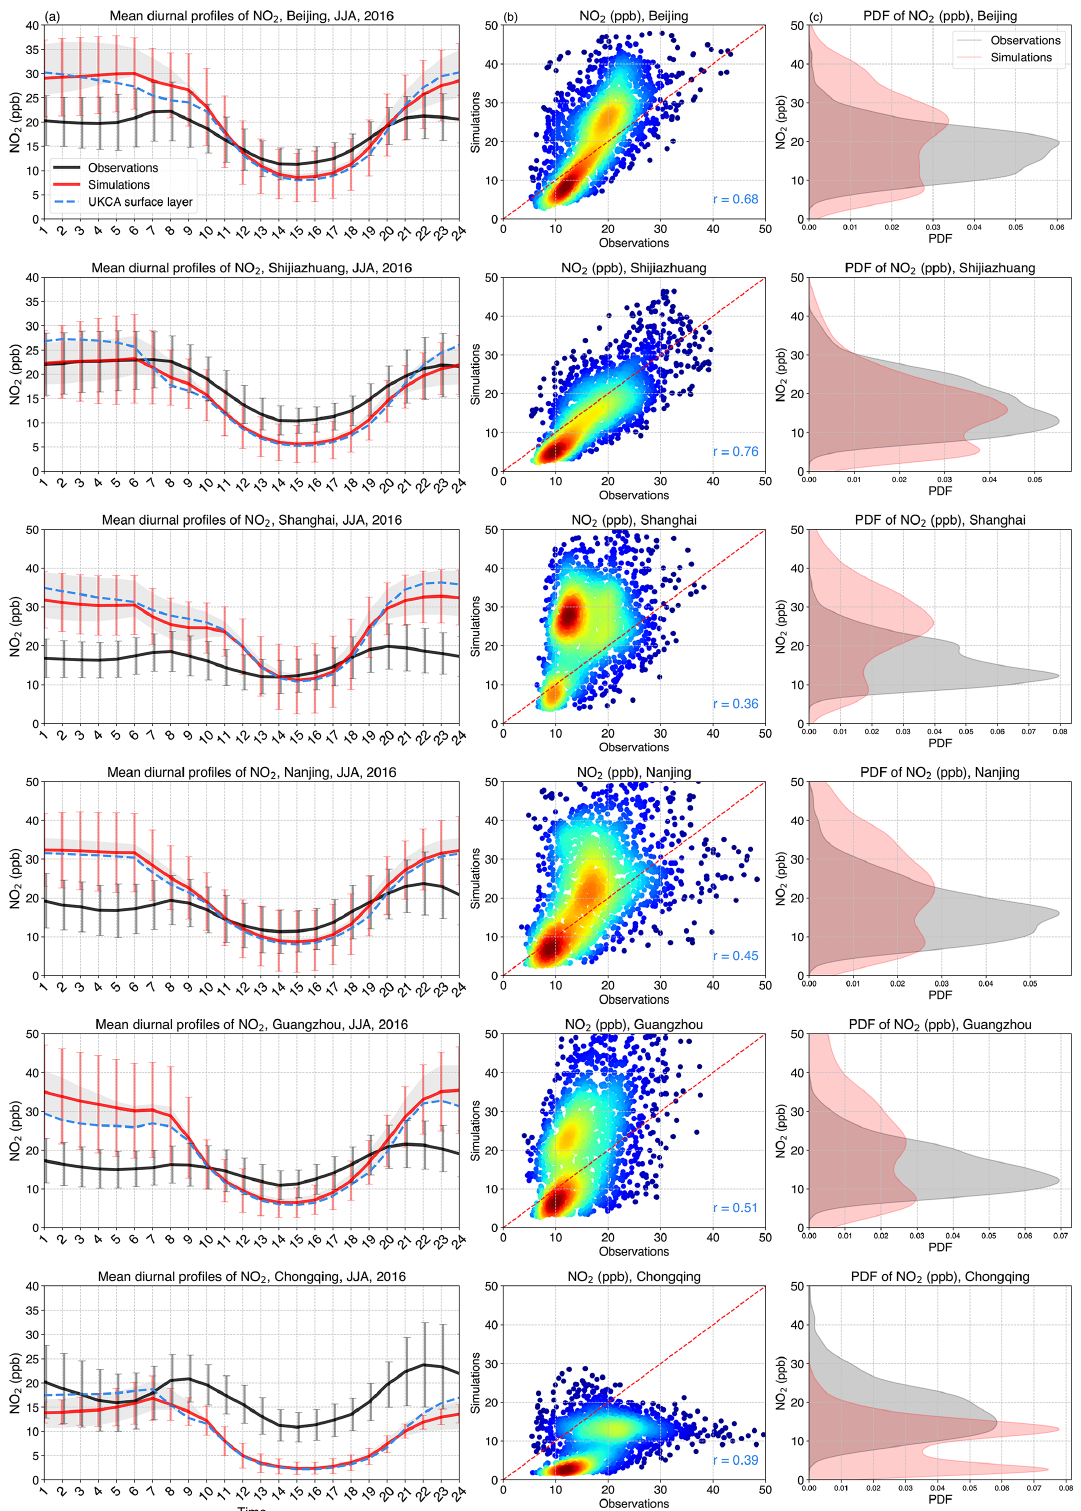
Figure 4. Comparison of observed and modelled NO 2 concentrations for the six industrialised regions in JJA, 2016, China. (a) Mean diurnal cycles of observed and modelled NO 2 concentrations (ppb). The shaded area represents the spread across the lowest three model layers. Error bars denote 1 standard deviation of hourly NO 2 concentrations across all days. (b) Observed and modelled hourly NO 2 concentrations (ppb; three lowest model layers) and correlation coefficient values r . (c) PDF of NO 2 concentrations (ppb) for modelled and observed hourly